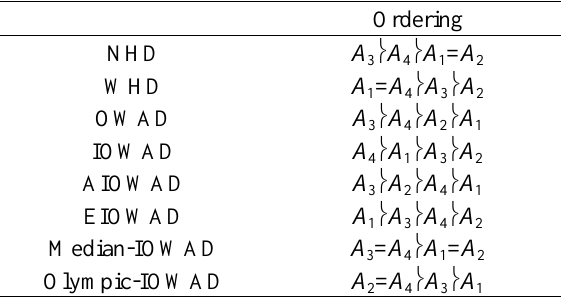
Table 6. Ordering of the